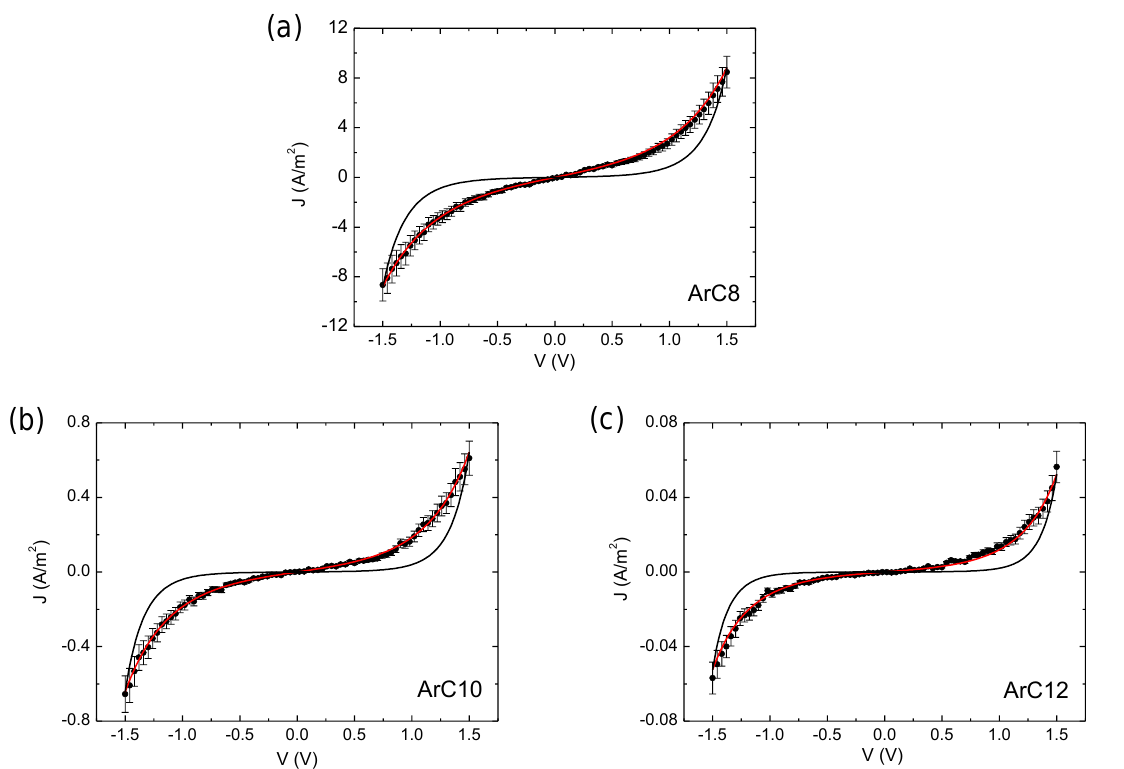
Figure 4. The statistically representative J–V curves (data points), obtained by averaging all the data measured at 78 K for ( a ) ArC8, ( b ) ArC10, and ( c ) ArC12 junctions. Black curves indicate the fitting results of the original Simmons model with a constant barrier height, and red curves denote the simulation of the VIBL-modified Simmons model.